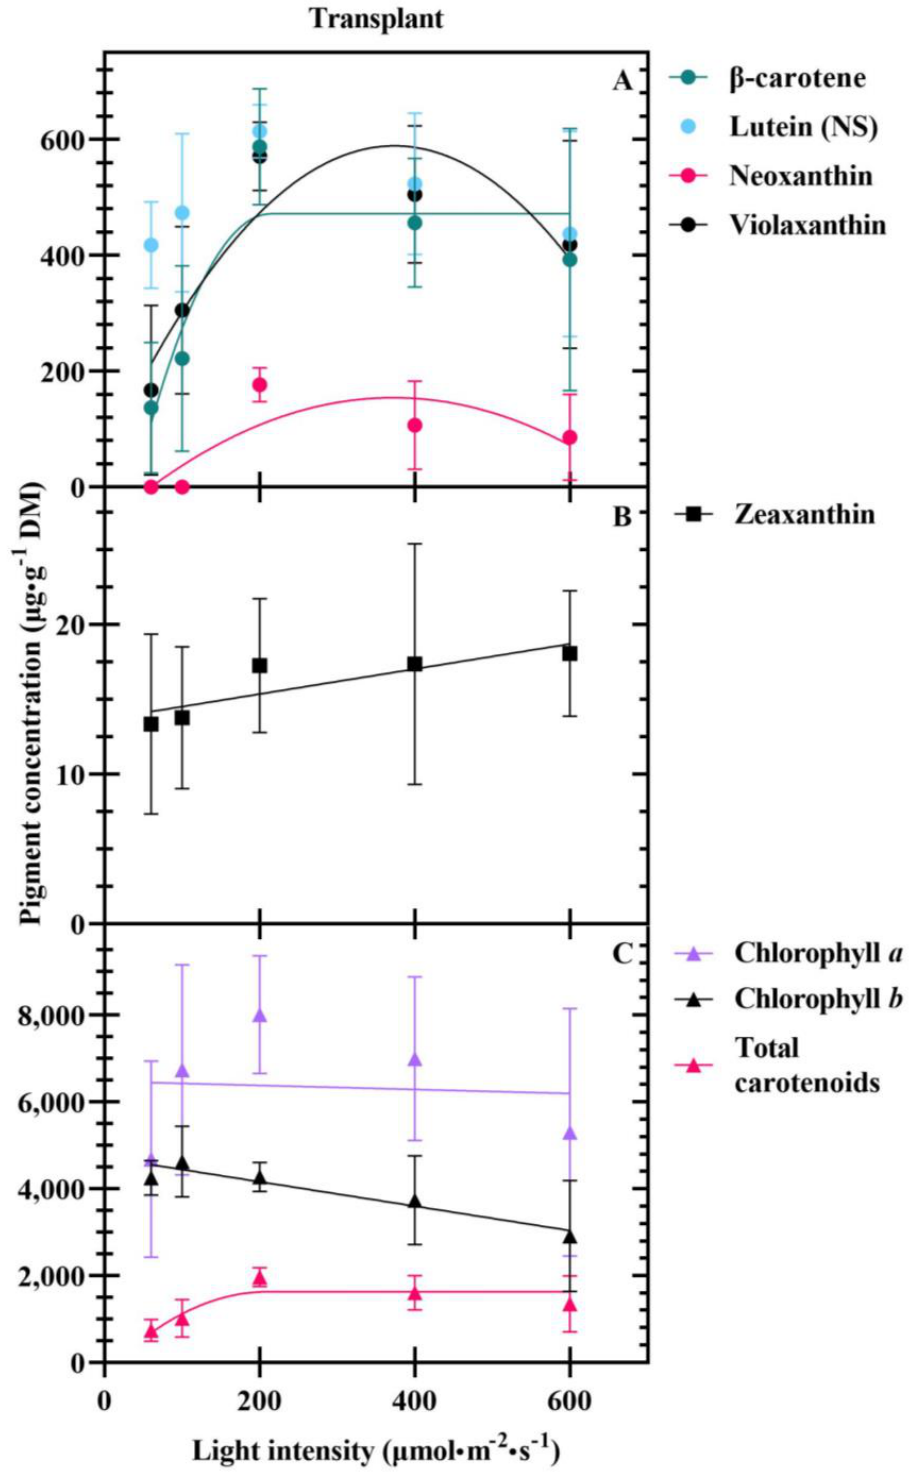
Figure 2. Concentrations [ µ g · g − 1 dry mass (DM)] of β -carotene, lutein, neoxanthin, and violaxanthin ( A ), zeaxanthin ( B ), chlorophyll a and b , and total carotenoids ( C ) of 14-day old butterhead lettuce ‘Rex’ ( Lactuca sativa ) seedlings grown under light intensities of 60, 100, 200, 400, or 600 µ mol · m − 2 · s − 1 for a 24-h photoperiod. Each symbol represents the mean of 12 plants ± SE. Lines represent linear, quadratic, or quadratic plateau regression. Equations and significance are reported in Table 3.